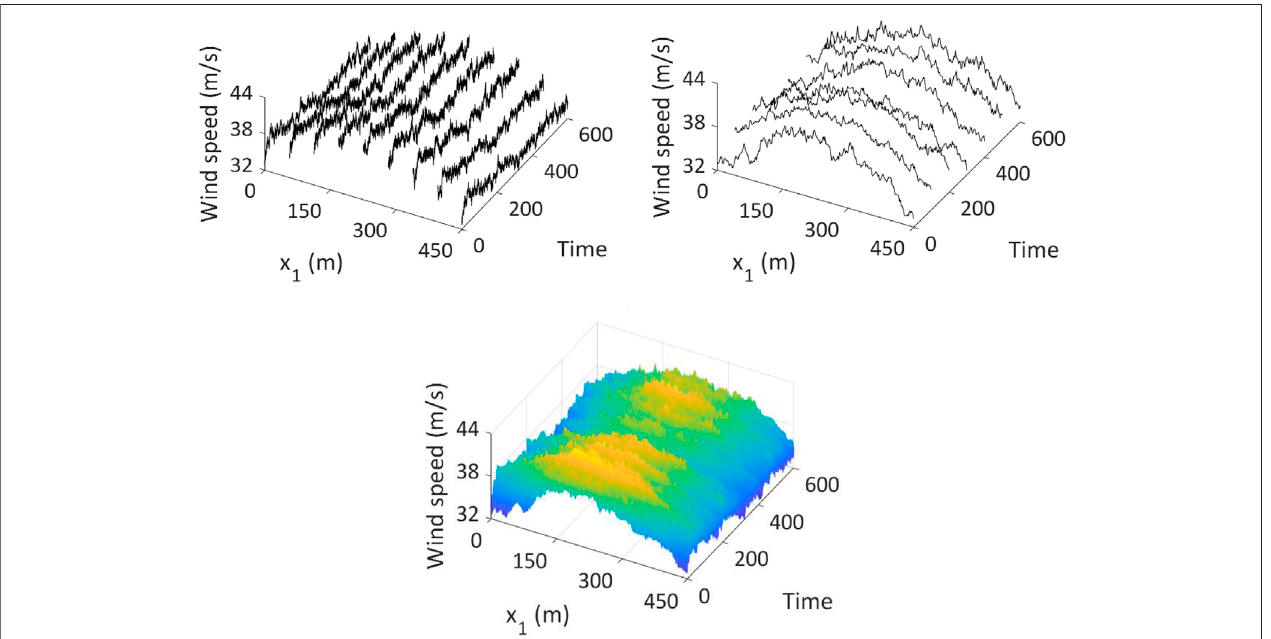
FIGURE2| Typicalsimulatednonhomogeneouspropagatingwind fi eld(theplotsincludethemeanwindvelocity): (A) showssimulatedwindvelocityplusthemean wind velocity at a few selected locations, (C) represents the wind velocity fi eld at a few selected time, and (B) shows the propagating wind fi eld along the bridge deck.